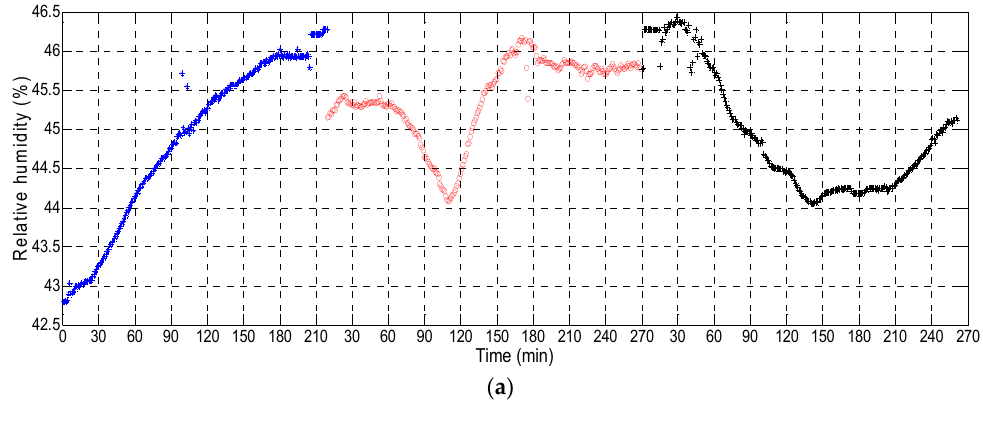
Figure 6. Cont. Figure 6. Cont.